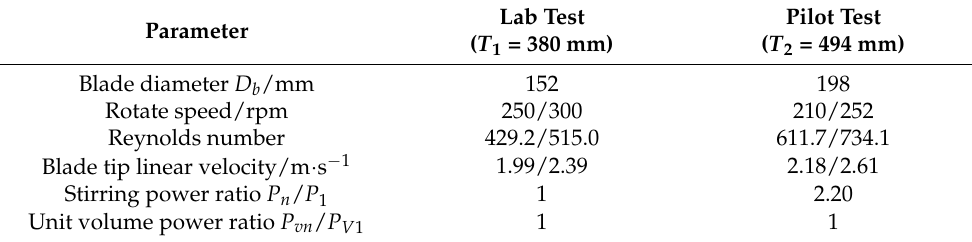
Table 9. Working condition parameters based on the same unit volume